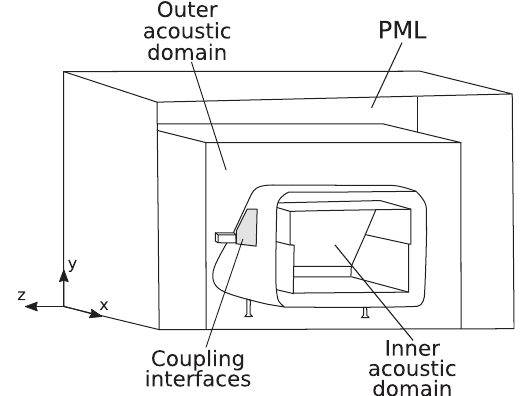
Figure 3. Schematic drawing of the simulation